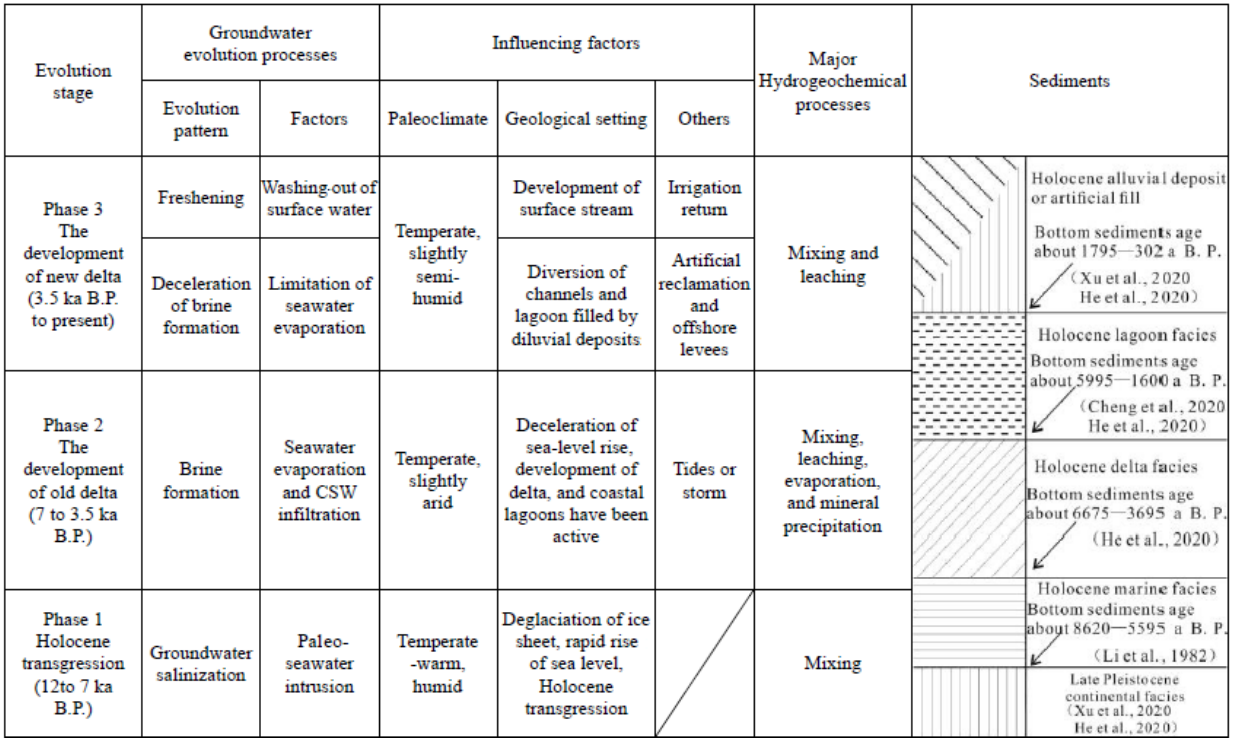
Table 1. Saline groundwater evolution processes in the study